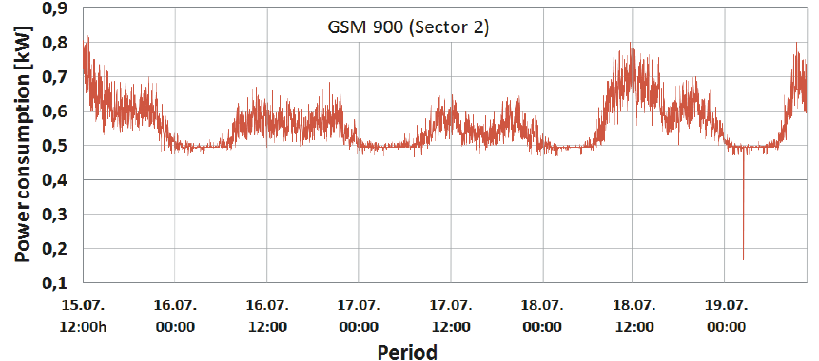
Figure 5. Power consumption of GSM 900 (Sector 2) BS cabinet.